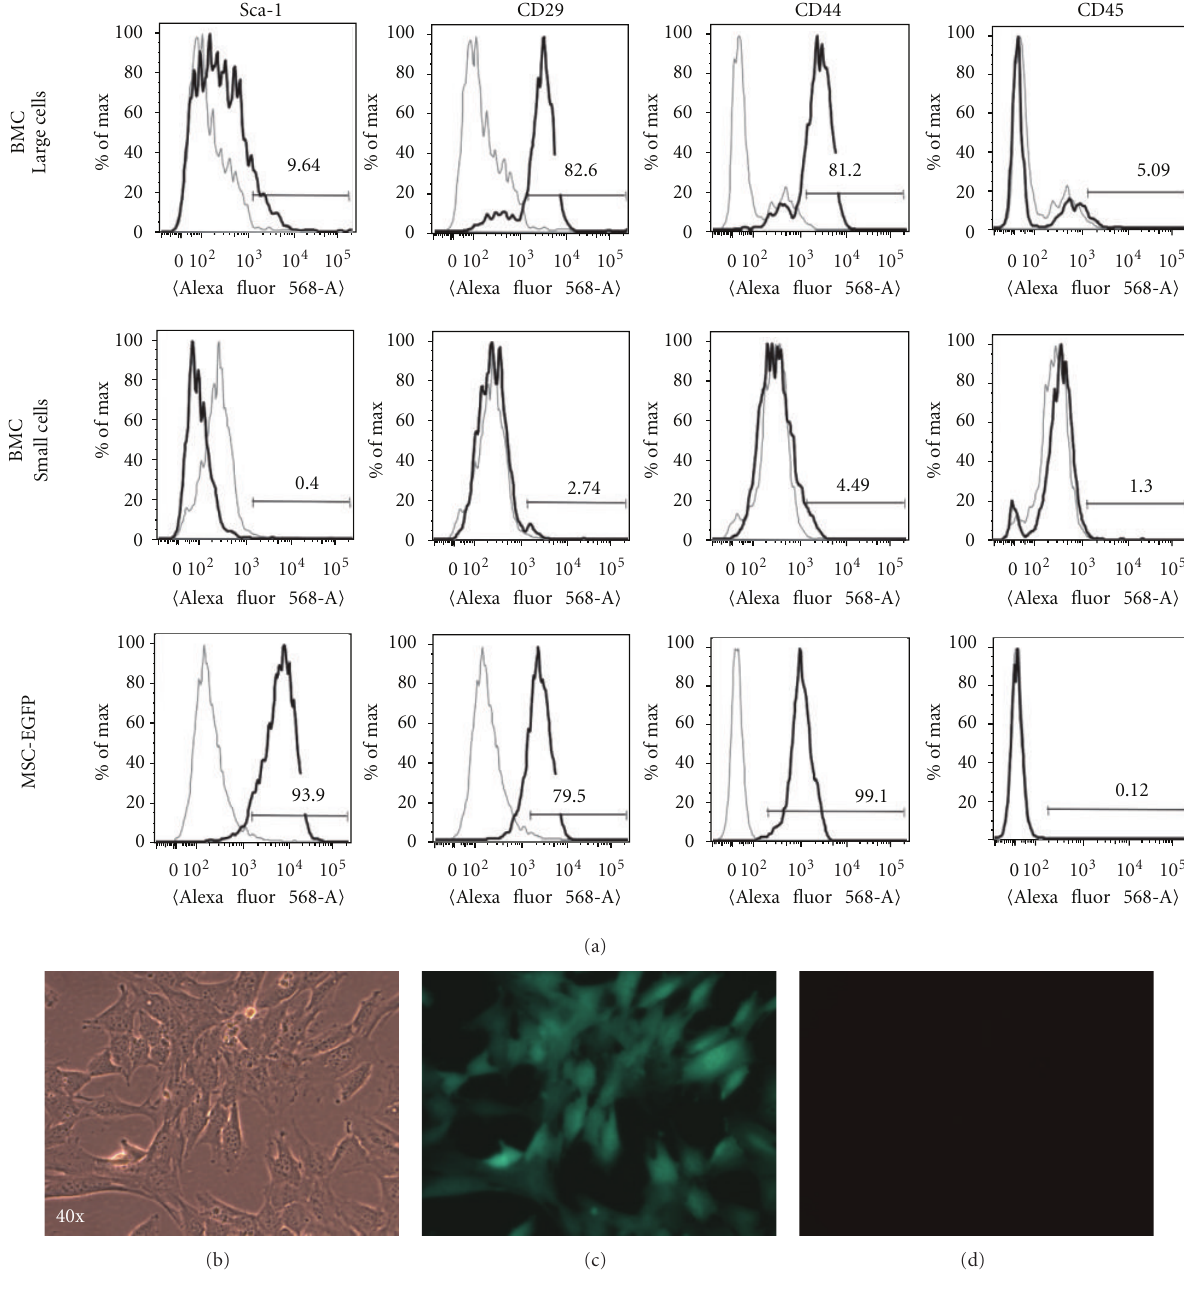
Figure 1: Phenotypic profiling of cultured BMCs and MSC-EGFPs. (a) BMCs cultured for three weeks in serum-containing mitogen- free conditions and mitogen-activated MSC-EGFPs at passage 18 were analyzed by Flow cytometry (FCM) using the Mouse Multipotent Mesenchymal Stromal Cell Marker Antibody Panel (R&D Systems). Shown are the positively staining markers Sca-1, CD29, and CD44, and an example of negative staining for the hematopoietic marker CD45. ((b), (c), (d)) Undi ff erentiated mesenchymal stromal cells derived from adult EGFP transgenic mice (MSC-EGFP) appear as large, flat fibroblast-like cells that express high levels of the enhanced green fluorescent protein reporter, EGFP. MSC-EGFPs are shown under (b) phase contrast and (c) GFP bandpass filter, demonstrating eGFP expression and (d) Texas Red bandpass filter, demonstrating lack of